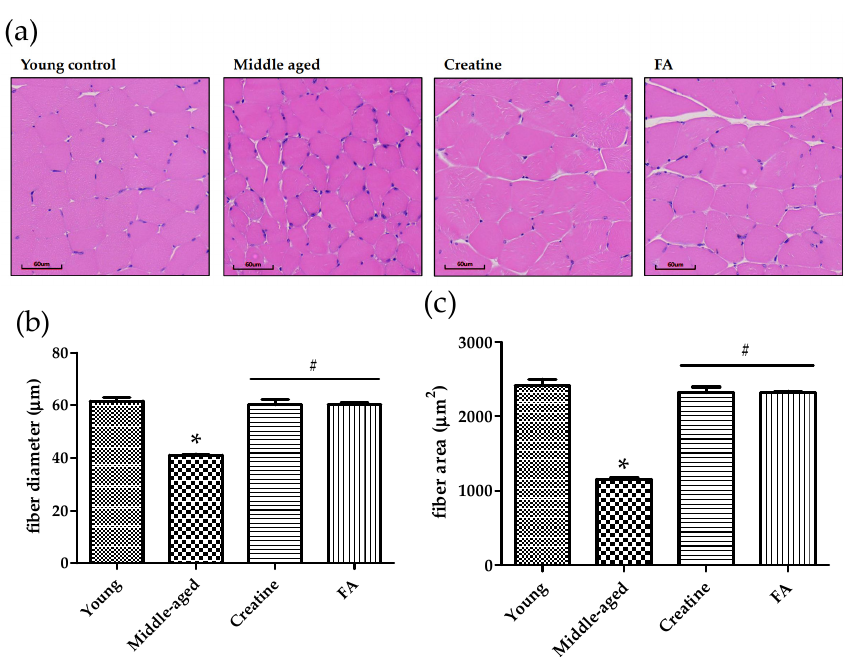
Figure 4. Skeletal muscle fiber stained-images, diameter and area. ( a ) Representative gastrocnemius muscle histological images, ( b ) quantification of skeletal muscle fiber diameter, ( c ) and fiber area. Data are expressed as the mean ± SD ( n = 3 mice per group), and p -values < 0.05 (*) as compared with the young control or p -values < 0.05 (#) as compared with the middle-aged control